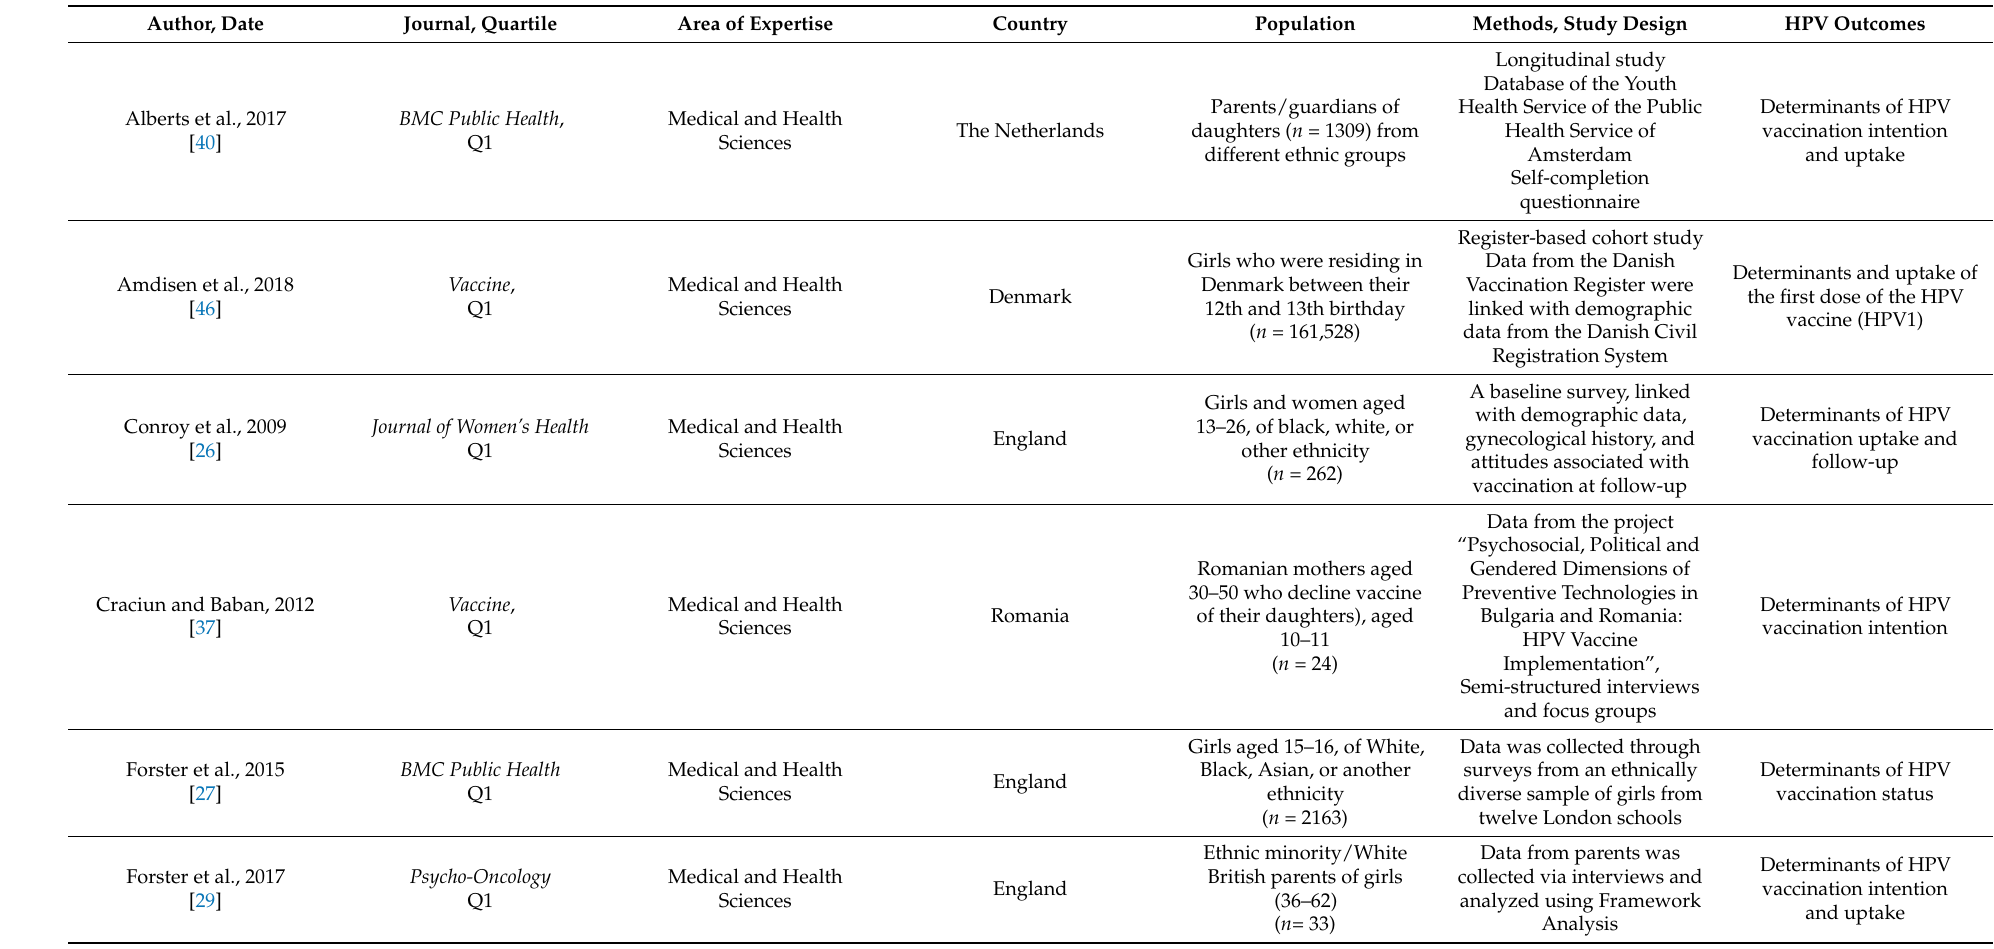
Table 1. Characteristics of the